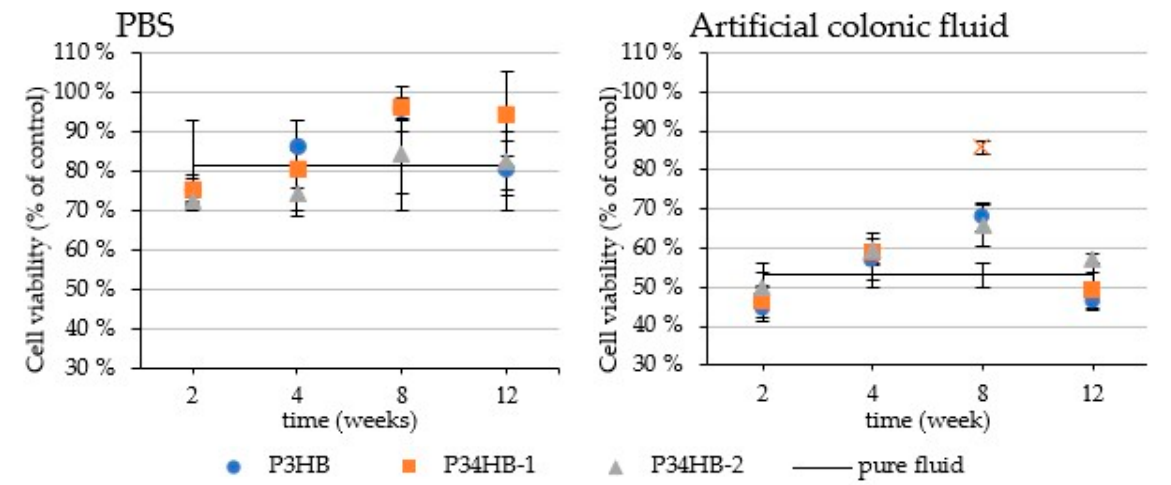
Figure 4. The influence of PBS and ACF after polymers incubation on the growth of Caco-2 cell culture expressed as percentual viability related to the fresh fluids. The data values (presented as means ± SD) are expressed as percentual viability related to the control (pure medium). A statistically significant difference ( p < 0.05) is indicated by a cross ( ✕ ).